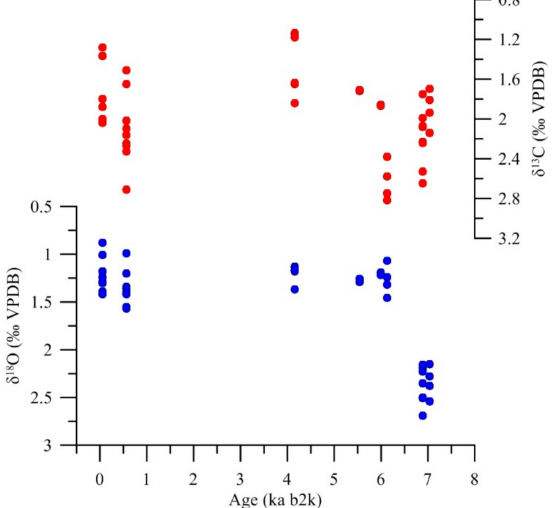
Figure 4. Oxygen and carbon isotope composition for fossil shells. Median calibrated radiocarbon age for each group is